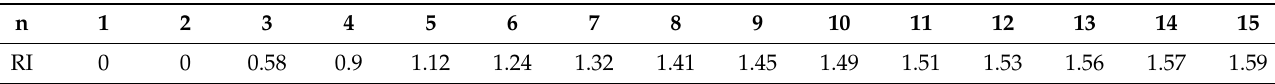
Table 2. Random Consistency Index (RI)